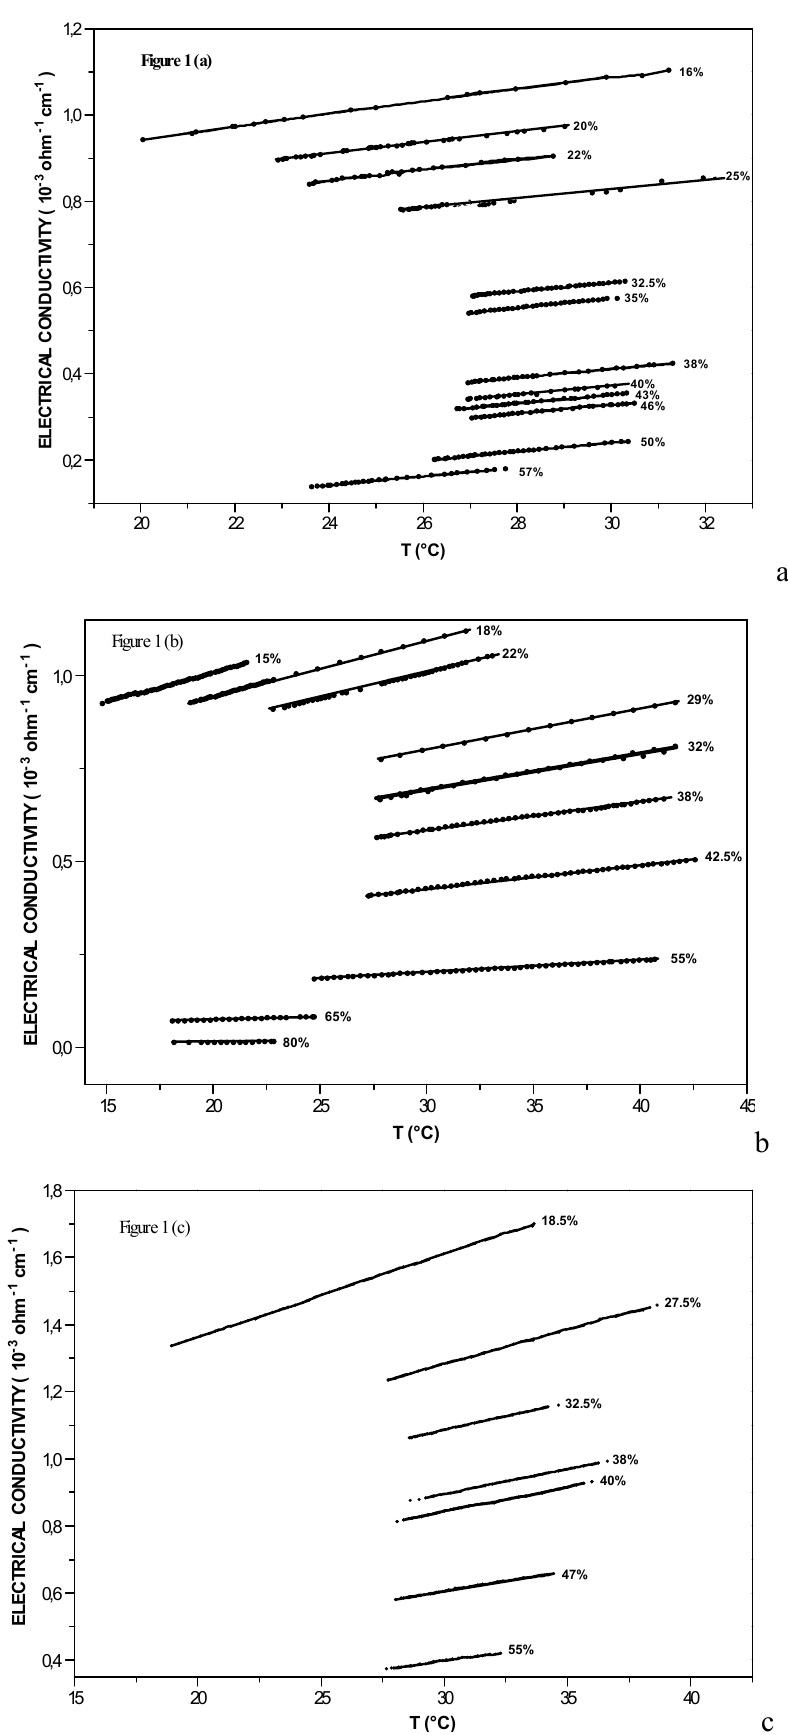
Figure 1. Temperature dependence of electrical conductivity along the coexistence curves in the single phase region of isobutyric acid–water (I-W): a)(I-W); b)(I-W) + 5 10 -4 M [KCl]; c) (I-W) + 5 10 -3 M